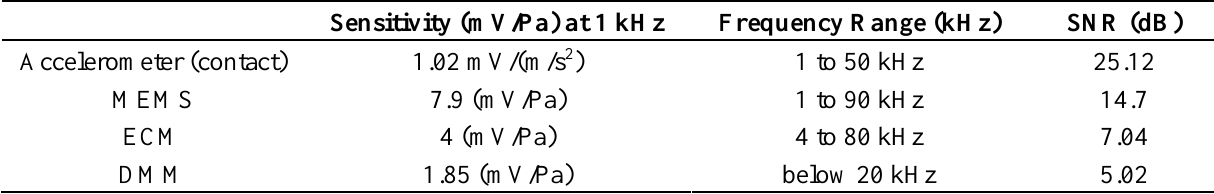
Figure 2. Set of tested sensors ( left ) and individual MEMS sensor unit ( right ). Table 1. Performance metrics of four sensors employed in this